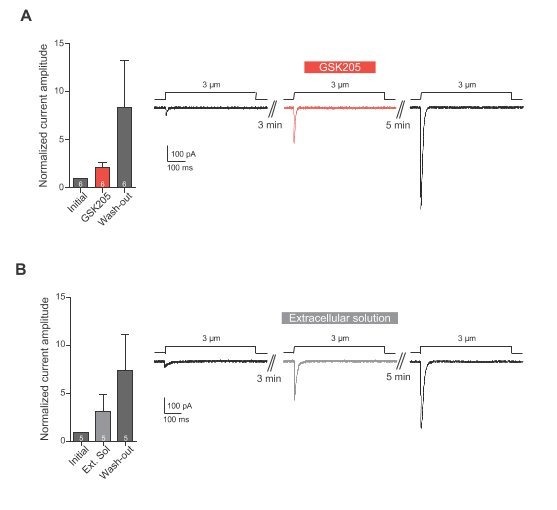
(A) Indentation of Neuro2A cells. Neuro2A cells were indented using a glass probe and resulting mechanically-gated currents were monitored using whole-cell patch-clamp. Indentation stimuli were applied before, during and after application of GSK205 (10 µM, 3 min; washout 5 min). Current amplitudes were normalised against pre-treatment currents. (B) Indentation experiments were repeated on cells treated with Extracellular solution instead of GSK205. Data represents average ± s.e.m., n = 6 cells (GSK205) vs 5 cells (negative control), from two separate experiments.